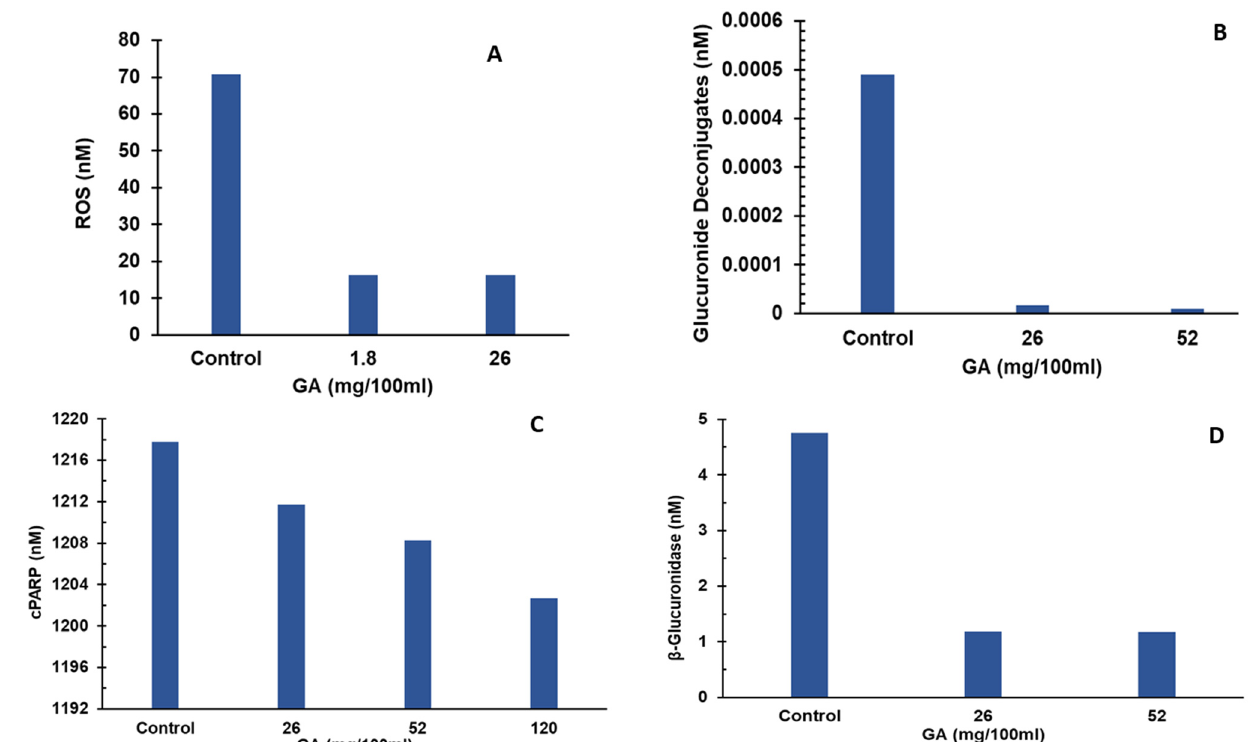
Figure 3. Effect of GA on liver toxicity pathways. ( A ) Effect of GA on ROS levels. GA supplementation led to reduction in reactive oxygen species concentrations compared to